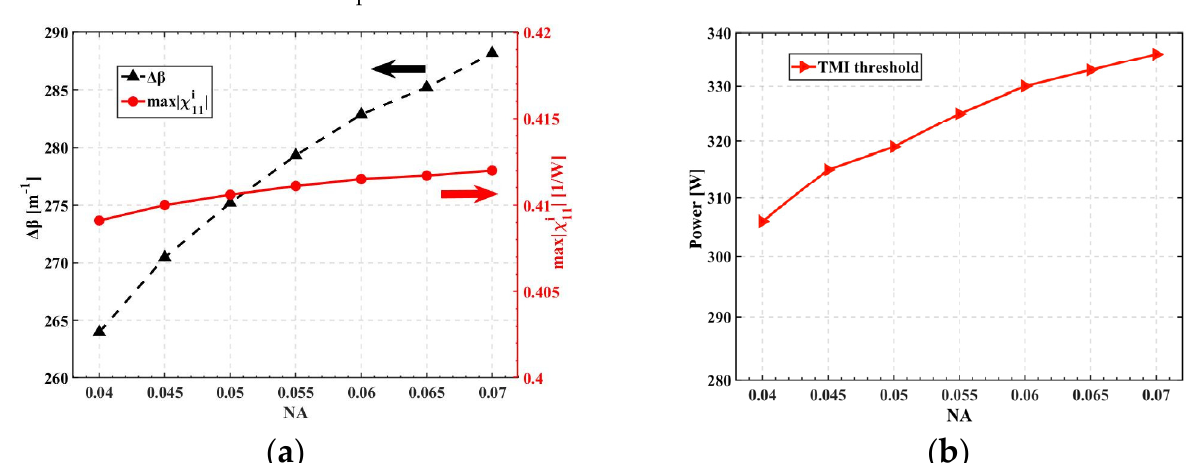
Figure 6. Relationship between NA and ( a ) wave vector difference between the fundamental mode and higher-order modes ∆ β and max , ( b ) the TMI threshold.